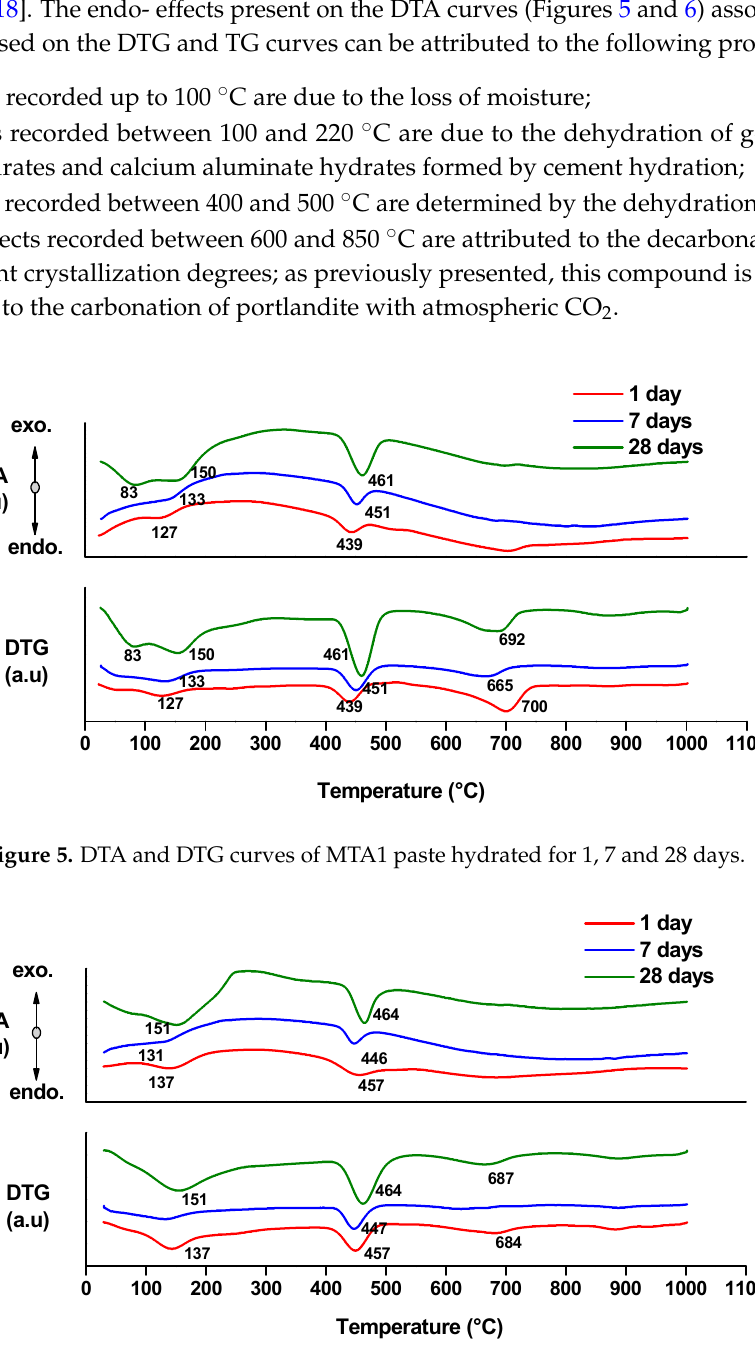
Figure 6. DTA and DTG curves of MTA2 paste hydrated for 1, 7 and 28 days.